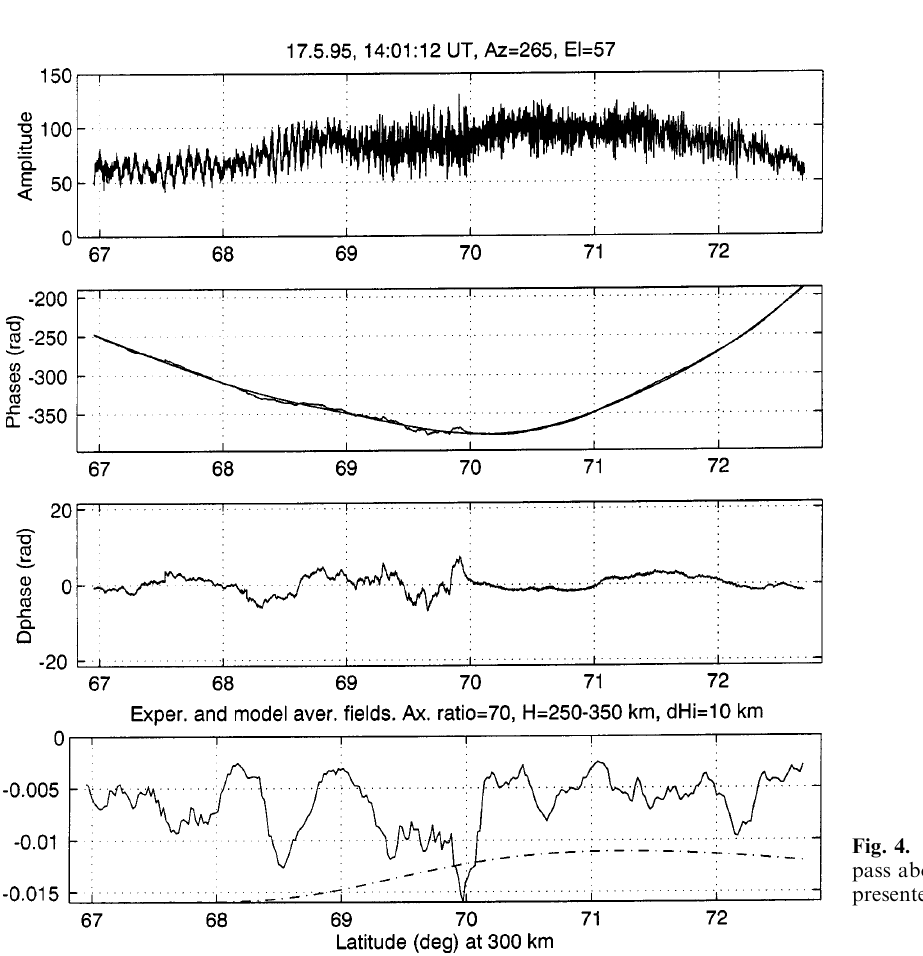
Fig. 4. Same as Fig. 1, but for the satellite pass about 2 h after the heating experiment presented in